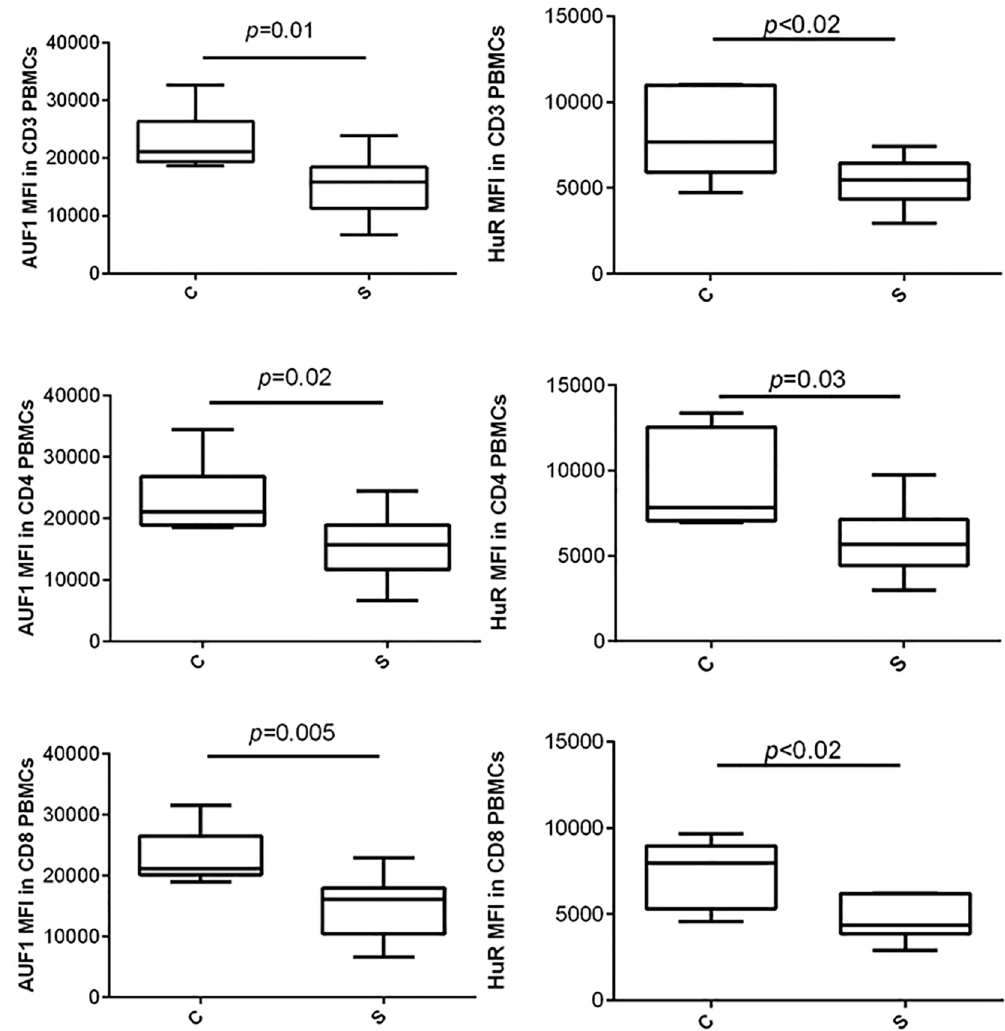
Fig 2. AUF1 and HuR protein expressions in CD3+, CD4+ and CD8+ T lymphocytes of peripheral blood obtained from the patients with pulmonary sarcoidosis and healthy controls. Legend: PBMC, peripheral blood mononuclear cells; MFI, mean fluorescence intensity. The data are expressed as whisker box plots; the box represents the 25 – 75th percentiles, the median is indicated by a bar across the box, the whiskers on each box represent the 10 – 90th